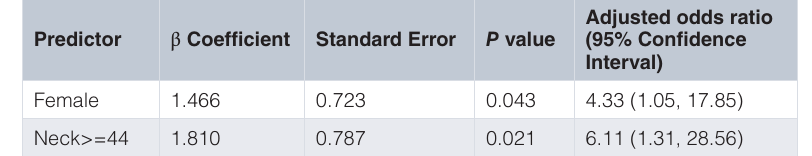
Table 5. Two independent predictors of LMA